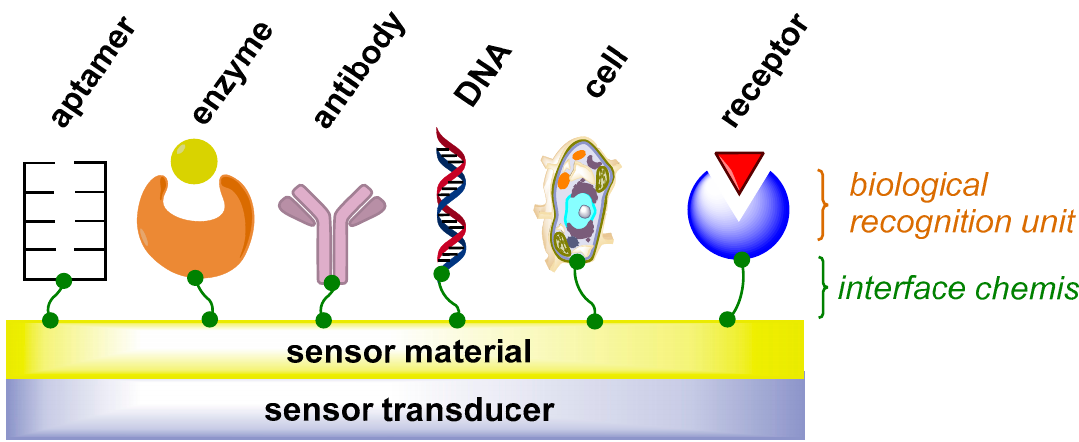
Figure 1. A schematic diagram of a biosensor. DNA: deoxyribonucleic acid.